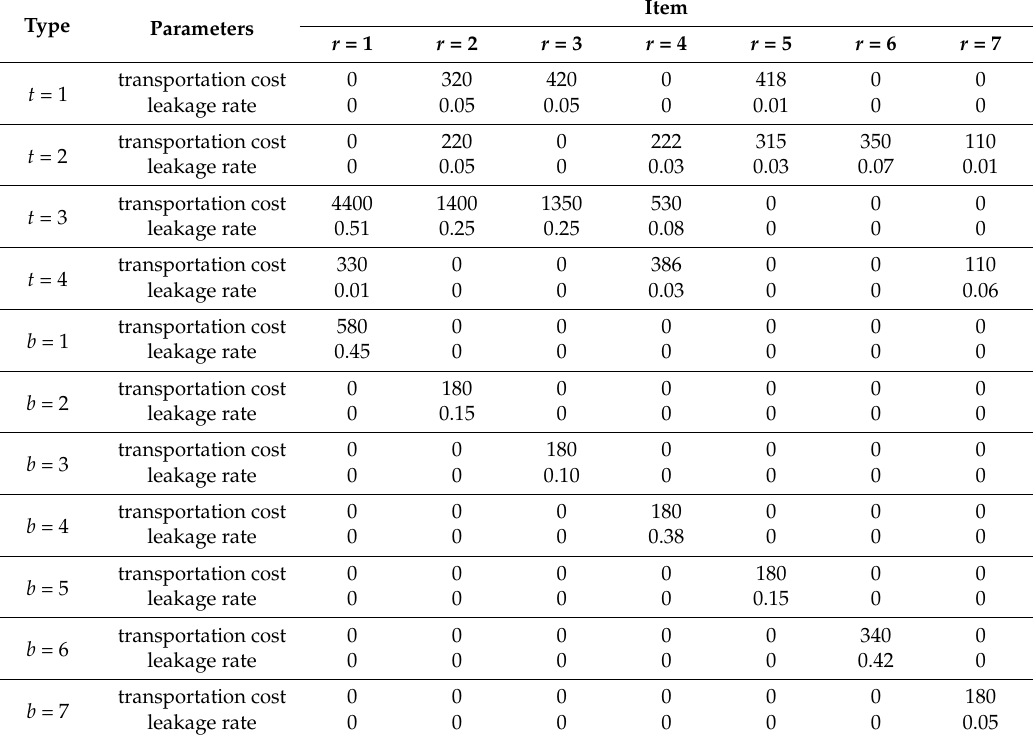
Table 2. The hydraulic connection among the nodes of the water supply